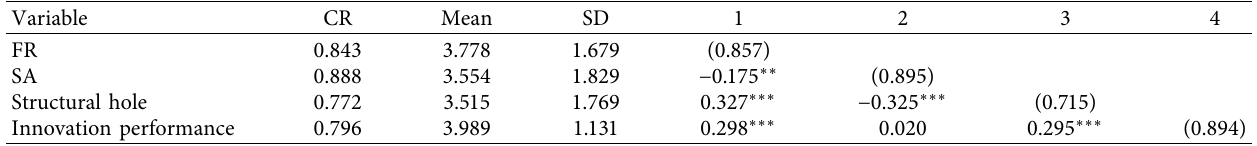
Table 2: Combined reliability, descriptive statistics, and correlation coefcient matrix of